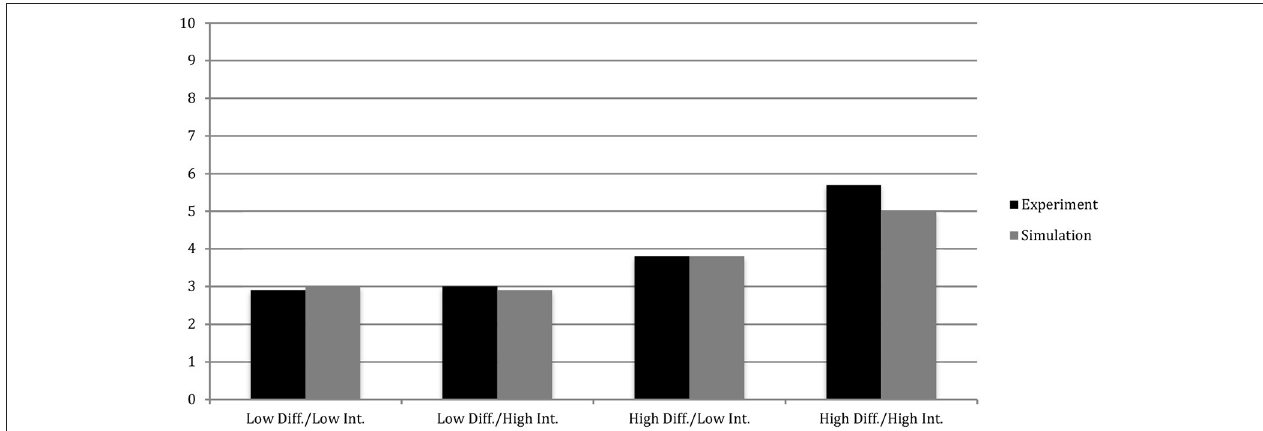
FIGURE 3 | Comparison of correct RAT solutions by condition between simulated results and human experiment data in Study 4 of Miron-Spektor et al. (2011). The R-squared statistics for the fit between the simulated and human data was 0.994 for Study 4.